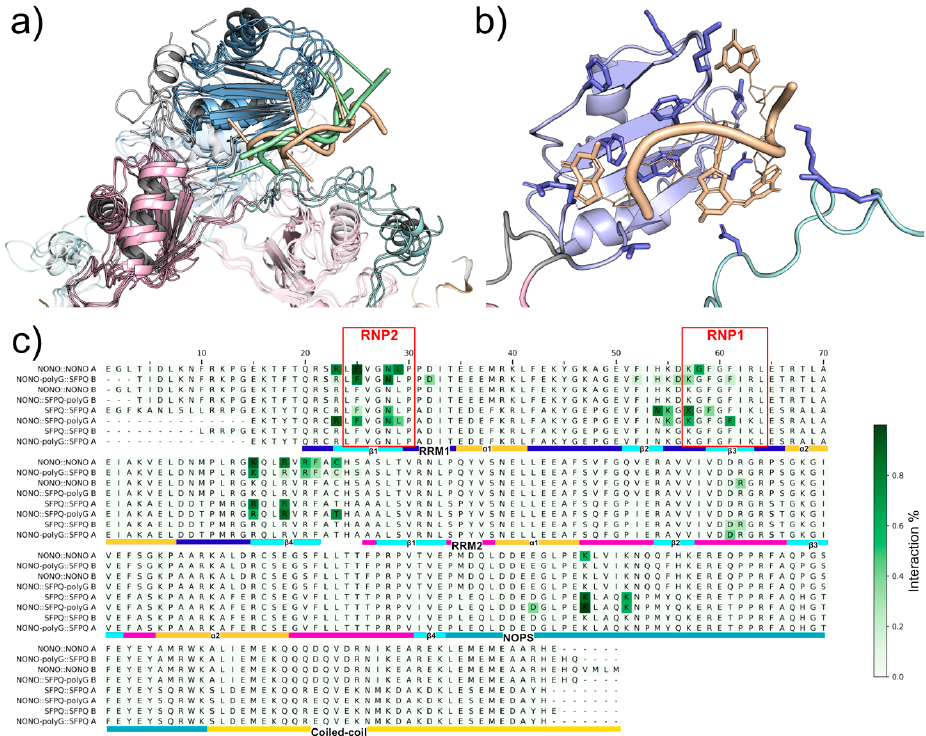
Figure 7. DBHS::polyG MD interactions. ( a ) Comparison of DBHS::polyG binding modes: NONO- bound (green), SFPQ-bound (yellow). ( b ) Representative binding mode of SFPQ bound to polyG in NONO::SFPQ, which has the most stable configuration; interacting residues are represented with blue sticks; polyG (yellow). ( c ) Interaction existence over simulation time: most DBHS::polyG interactions happen within RRM1s; however, the other chain β 2/ β 3 loop can assist with RNA binding. Sequence ordering: NONO bound to polyG in N::N (1) and N::S (2); NONO unbound in N::N (3) and N::S (4); SFPQ bound to polyG in S::S (5) and N::S (6); SFPQ unbound in S::S (7) and N::S (8).